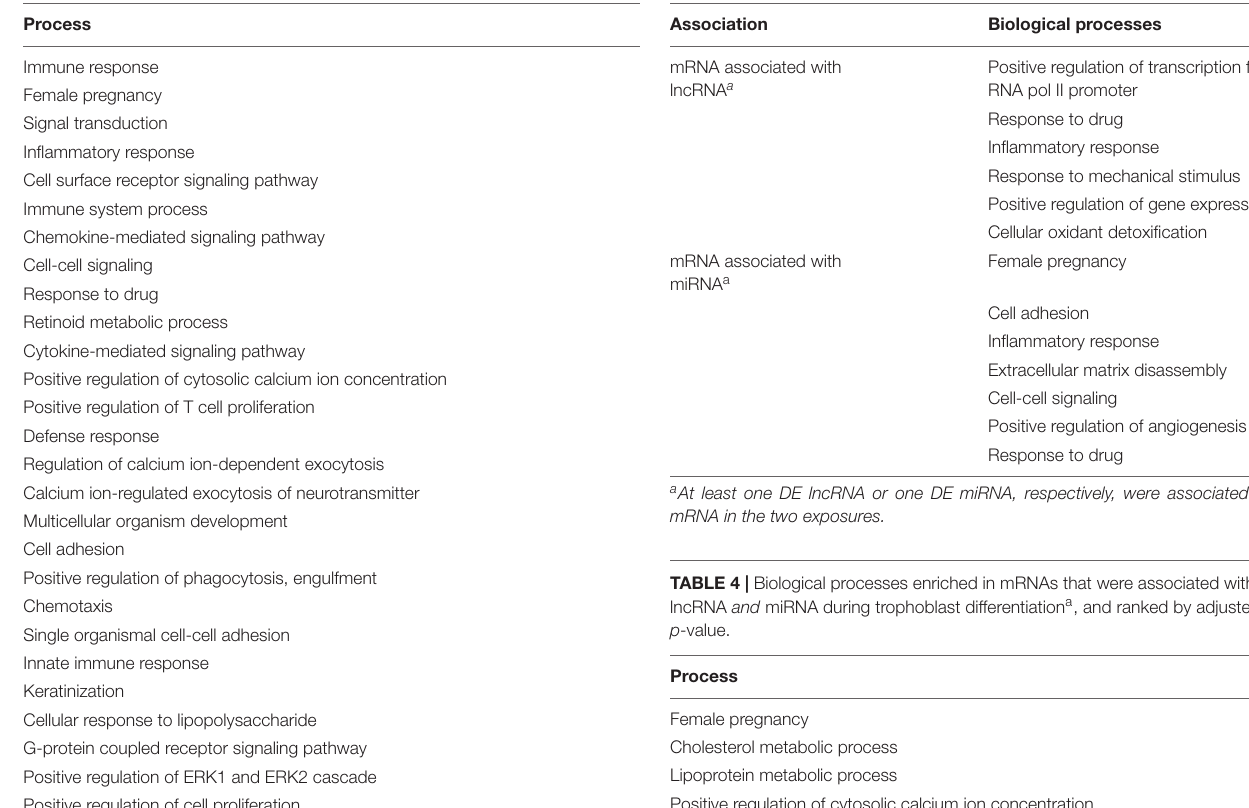
TABLE 3 | Biological processes enriched in mRNAs that were associated with lncRNA or miRNA during trophoblast differentiation, and ranked by adjusted p -value.